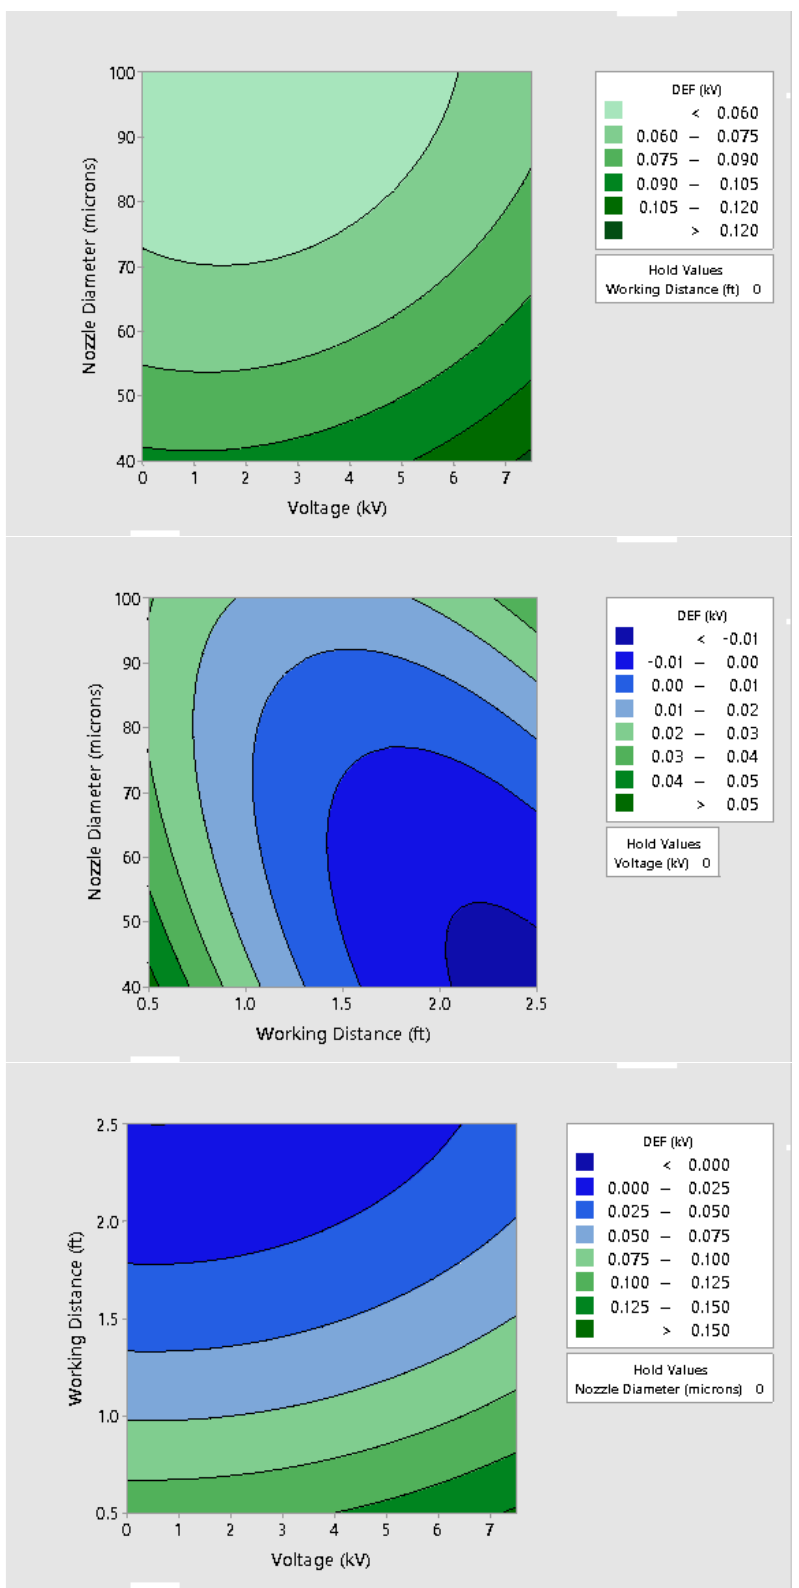
Figure A16. Stainless steel: quantitative representation of average differential electric field vs. working distance (feet), nozzle sprayer size ( µ m), and charge voltage